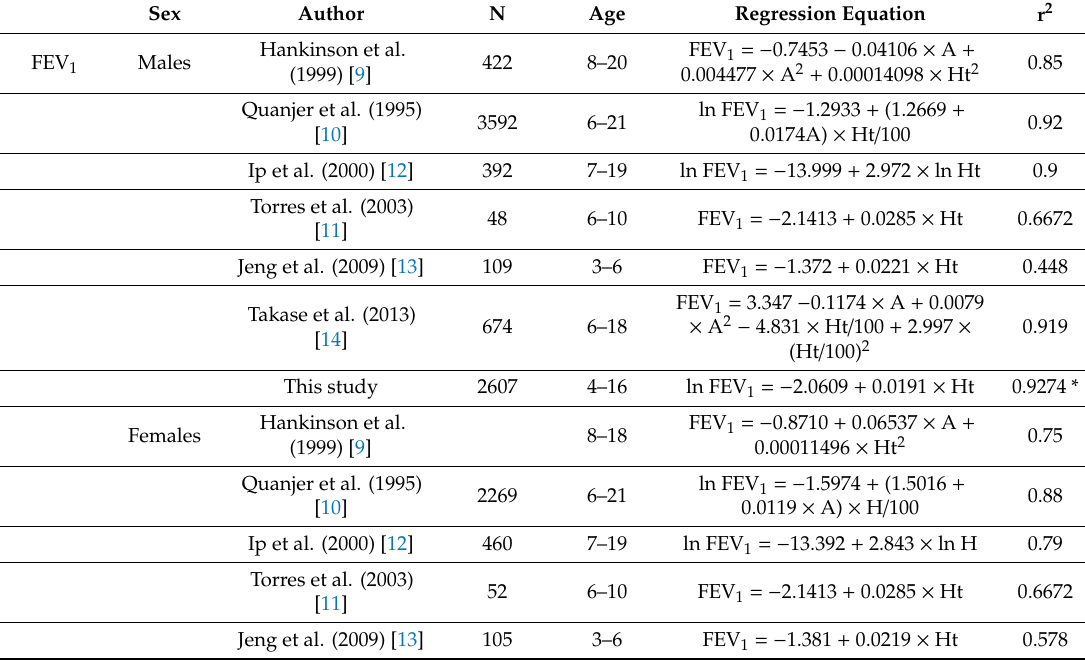
Table 5. Comparison of predicted values of the FEV 1 and FVC with previous foreign